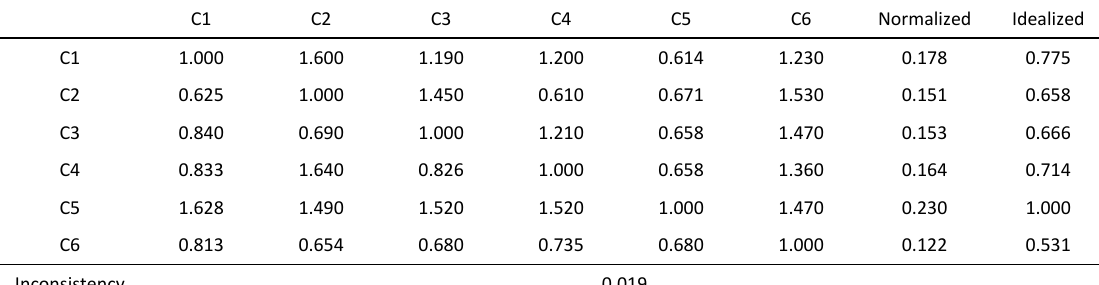
Table 5. Pairwise comparison matrix of main criteria in comparison with the purpose.